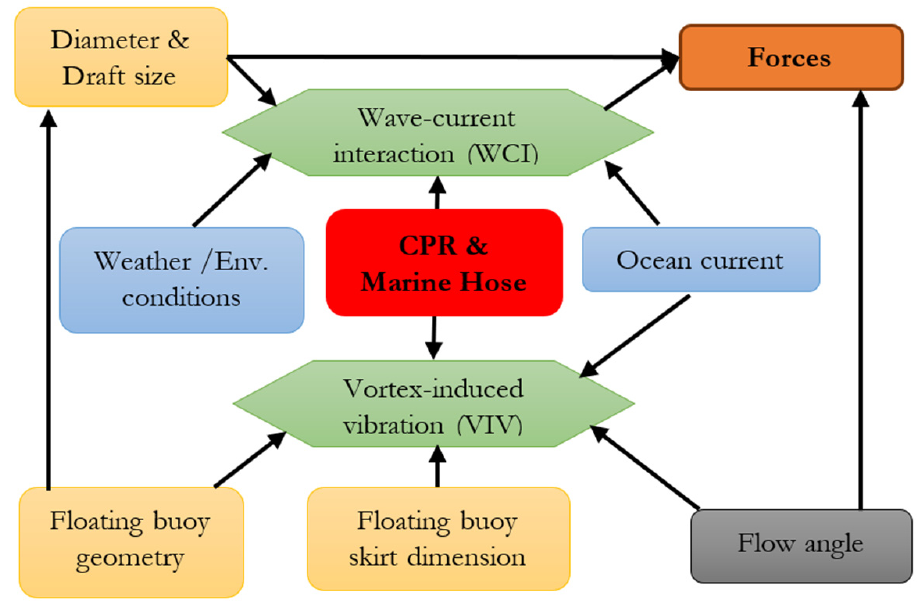
Figure 10. Wave–current interaction and vortex-induced vibration and motion response on a floating